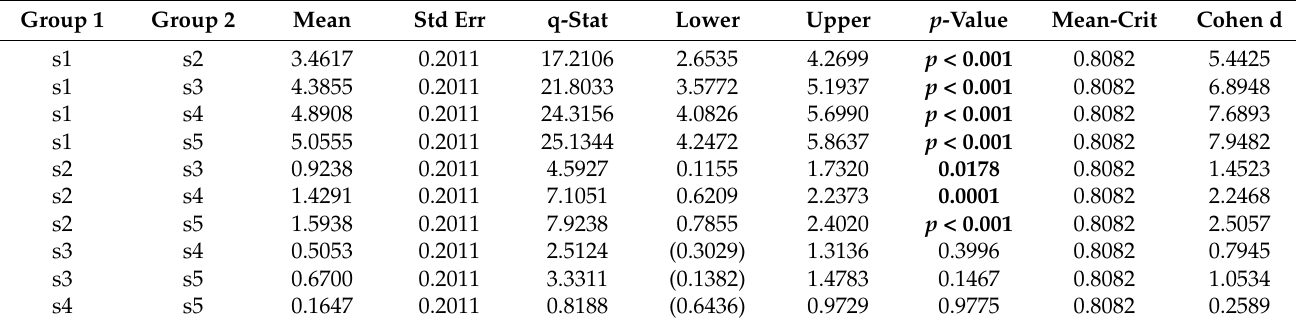
Table A7. Tukey’s HSD Post Hoc Test results regarding ResNet152 (cid:48) s test accuracies of various training set sizes. Group